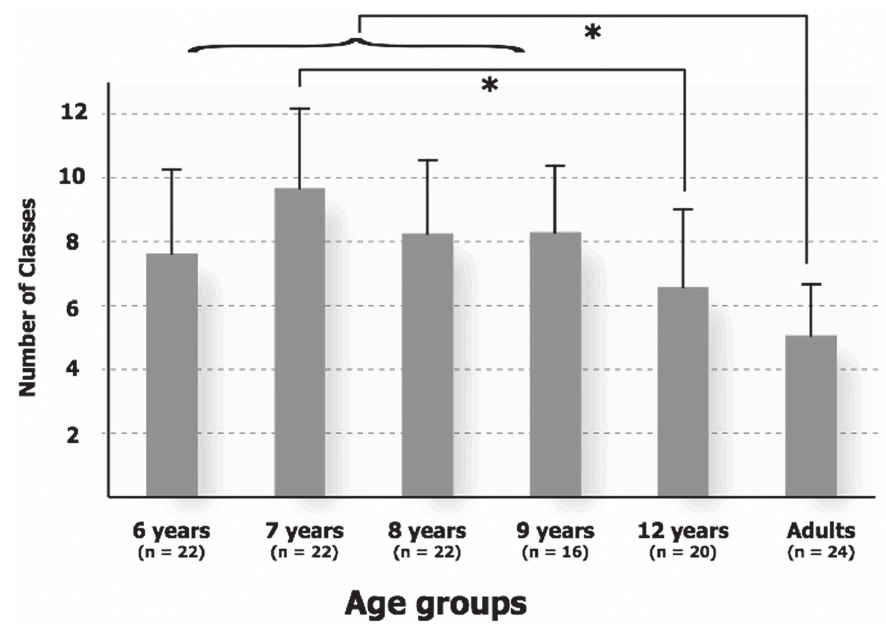
Fig 3. Average number of classes as a function of age of the participants. Standard deviations are depicted for each age group. Significant differences between age groups are represented by the brackets and astericks (representing p <